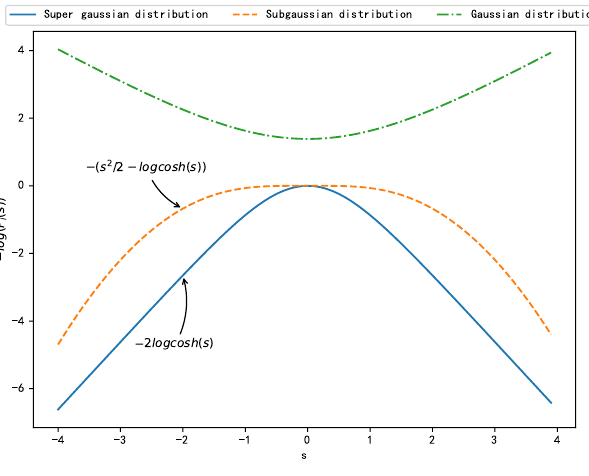
Figure 3. Estimation of negative logarithmic probability density corresponding to different distribu-